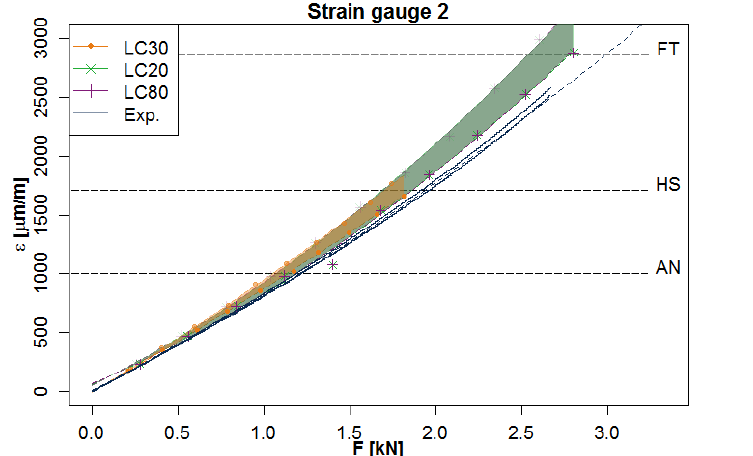
Fig. 9 Load-strain diagram for the measuring point strain gauge 1 of the specimen with R = 1083 mm h = 8 mm, C = 1100 mm and B = 360 mm Thus, loading condition LC 30 cannot cover the strain area, which is reached in the experimental test. Overall, the displacement controlled load introduction through contact elements (LC 30) struggles especially with small thicknesses and small radii, as the large deformations of those parameters lead to convergence problems. Fig. 10 is showing the appropriate principle stress distributions between the bending rollers, which is defined as the loaded area. The force controlled loading conditions are compared at an introduced force of 2.24 kN as an example. They nearly show the same distribution. In the middle of the specimen, the stresses are about 160 N/mm², towards the edge they first decrease by about 10 N/mm², before they increase to 170 N/mm². The distribution reflects the non-linear load- bearing behaviour, which occurs due to lateral stresses and underlines the need of correction factors to describe the uneven stress distribution respectively. The displacement controlled loading conditions are looked at an introduced load of 36 mm. The stress distribution of the direct load introduction (LC 90) is showing a peak stress at the edge under the bending roller. This result did not represent the experimental data sufficiently.